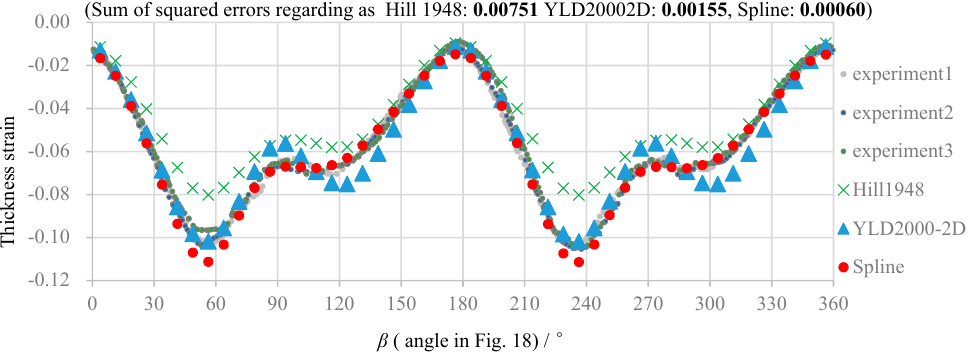
Figure 27. Thickness strain distributions on circle 1 in experimental condition F.